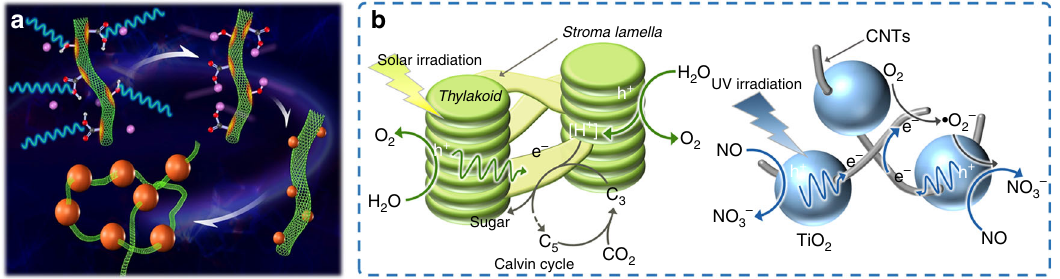
Fig. 6 The mechanism illustration for CNTs as microwave antennas and chloroplast structures in photosynthesis as well as photocatalysis. a Schematic illustration of the CNT-TiO 2 preparation process: microwave absorbing and converting into super-hot dots (red dots), Ti 3 + ions (purple dots) adsorption onto super-hot dots, Ti 3 + hydrolysis into TiO 2 crystal seeds (small brown dots), and TiO 2 nanocrystals (big brown dots). b The photosynthesis mechanism of chloroplast (left) and the photocatalytic NO removal mechanism of chloroplast structured CNTs-TiO